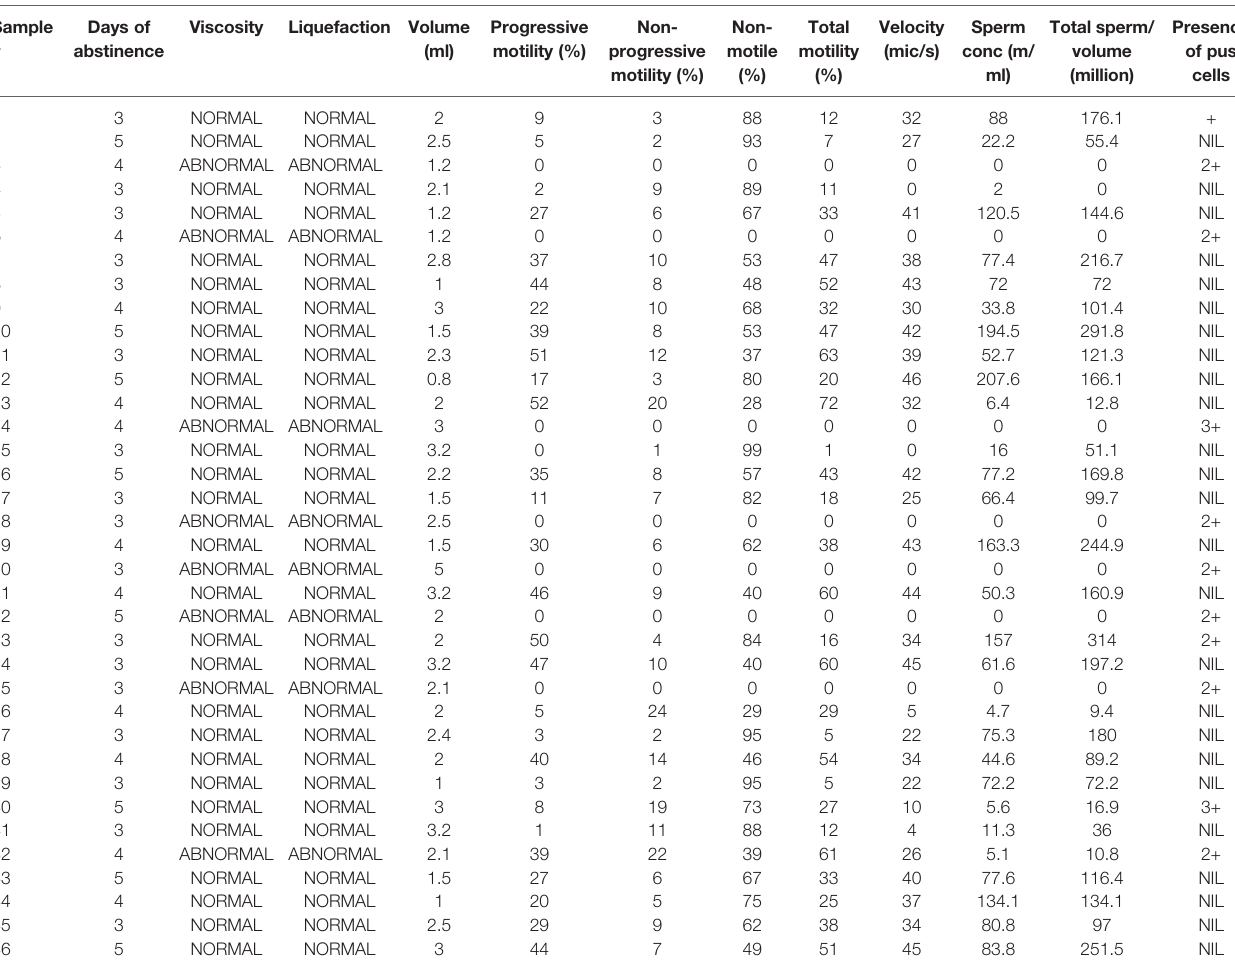
Key: NIL represents absence of pus